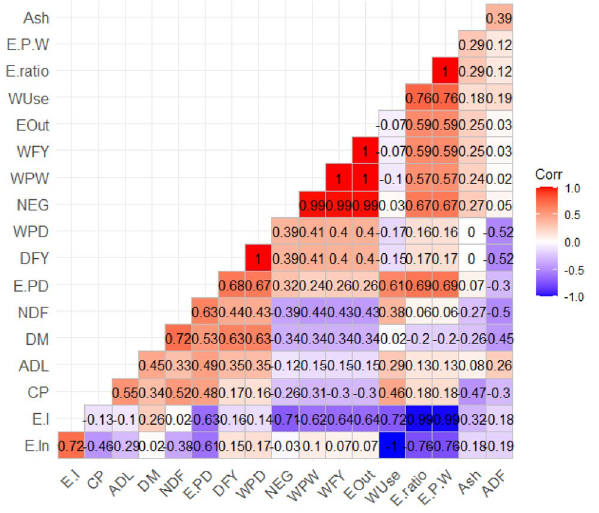
Fig. 4 Correlation plot for measuring association between meas- ured traits of maize 80% under full irrigation. W Use: water use, E.ratio: energy ratio, E.PW.: energy productivity of wet forage yield, ADF: cell wall hemicellulose free, E.I: energy intensity, ADL: lignin, NDF: neutral detergent fiber, DM: dry matter, CP: crude protein, E.P.D: energy productivity of dried fodder yield, DFY: dried fodder yield, W.P.D: wet forage yield, E.In: input energy, WP.W: water pro- ductivity of wet forage, N.E.G: net energy gain, WFY: wet forage yield, E.Out: output energy